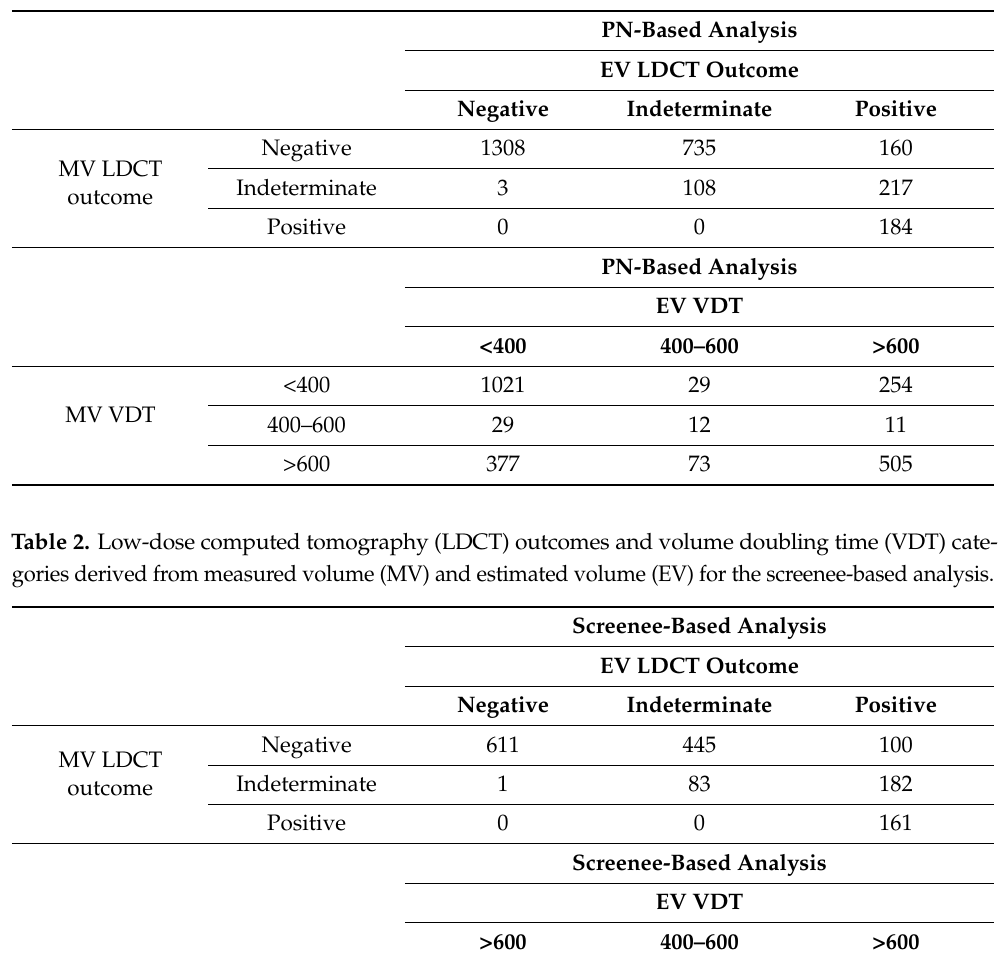
Table 1. Low-dose computed tomography (LDCT) outcomes and volume doubling time (VDT) cate- gories derived from measured volume (MV) and estimated volume (EV) for the PN-based analysis.